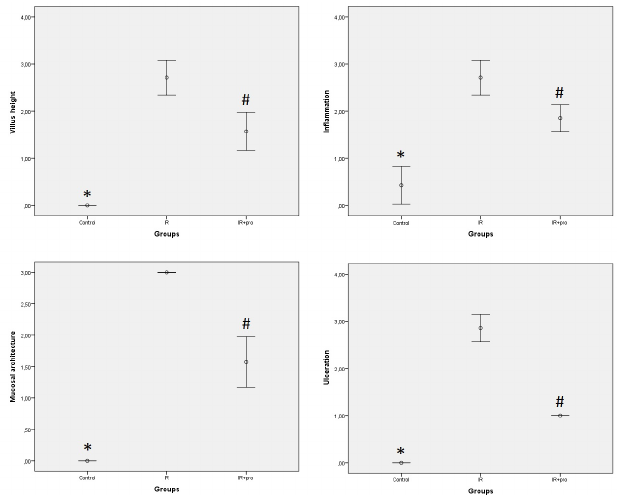
Fig. 3 - Results of histopathological damage scores of ileal tissue. *P<0.05 compared to the IR and IR+Pro groups. # P<0.05 compared to the IR group.